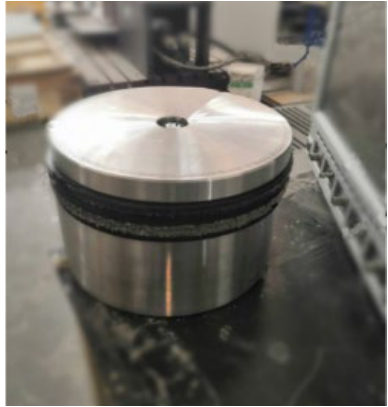
Figure 2. A prototype of a wireless WIM sensor.